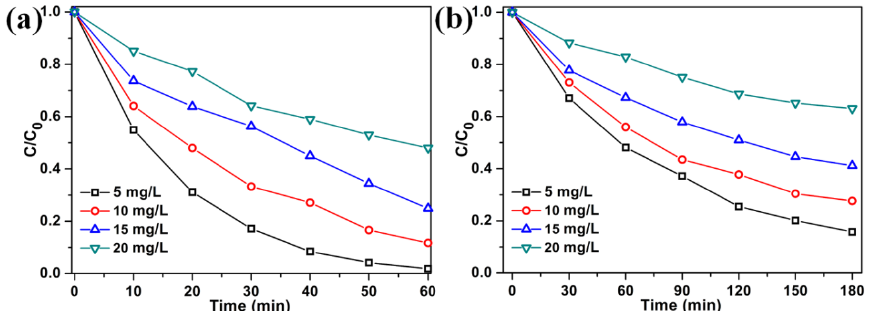
Figure 6. The effect of the initial concentrations of RhB ( a ) and methyl orange (MO) ( b ) on the photocatalytic activity of 3%M-Bi (10 mg).